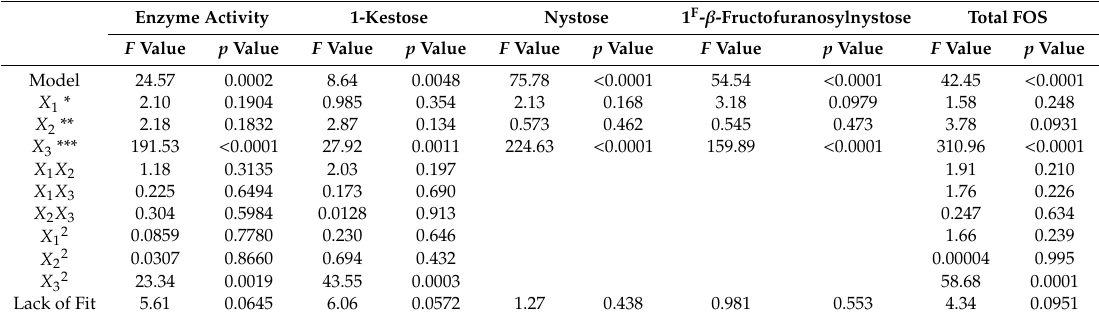
Table 2. Analysis of variance (ANOVA) for the response surface quadratic model for FOS production. Enzyme Activity 1-Kestose Nystose 1 F - β -Fructofuranosylnystose Total FOS